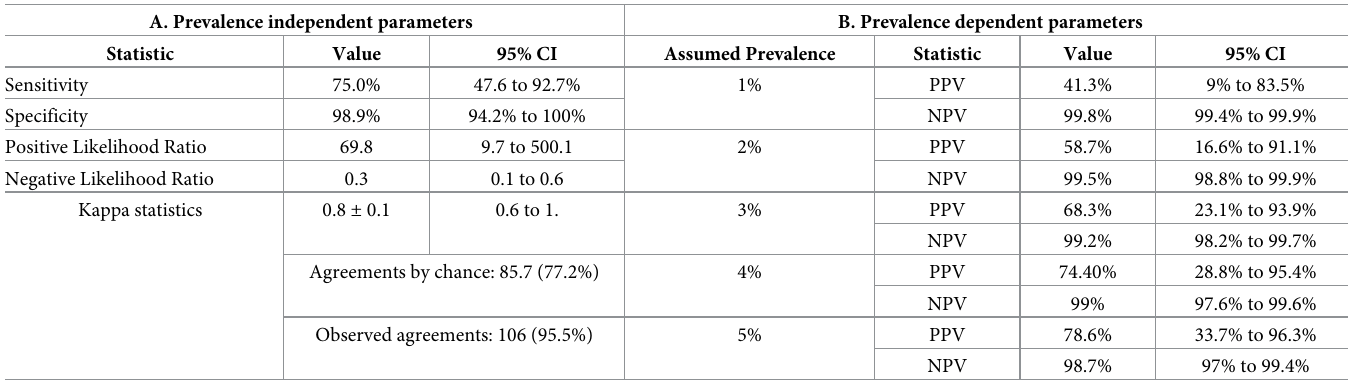
Table 2. Diagnostic characteristics of the pooled sample analysis